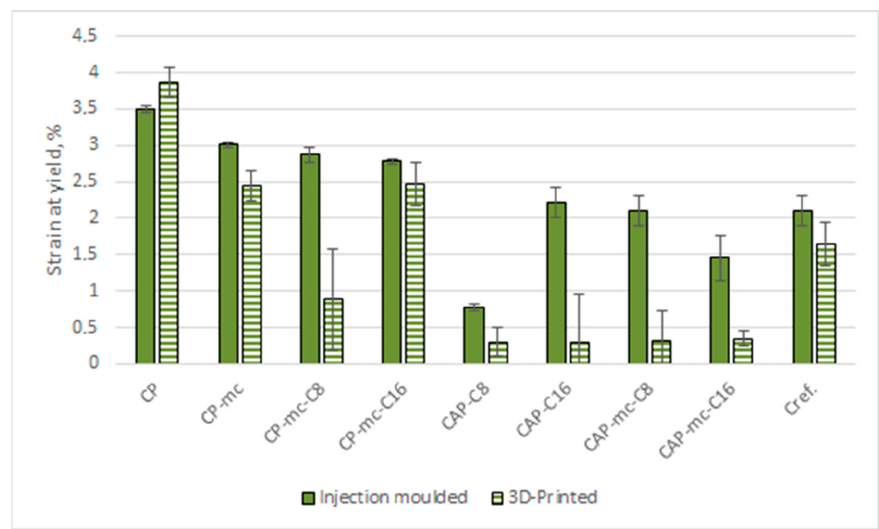
Figure 9. Strain at yield for injection molded and 3D printed materials. CP is commercial cellulose acetate propionate with 13% commercial plasticizer; CP-mc is 20% microcellulose containing CP; CP-mc-C8 contains also 4% cellulose octanoate C8; CP-mc-C16 contains 4% of cellulose palmitate C16; CAP-C8 contains neat cellulose acetate propionate (CAP) with 17% C8; CAP-C16 contain 17% C16 in CAP; CAP-mc-C8 contains 20% mc and 17% C8 in CAP; CAP-mc-C16 contains 20% mc and 17% C16 in CAP and Cref is PLA-based material with 20% cellulose